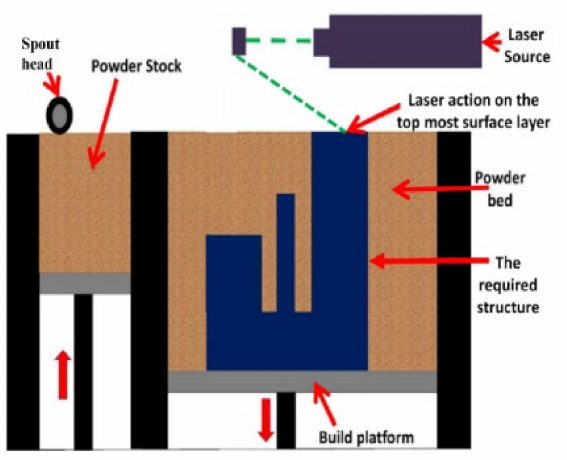
Figure 7. Schematic of SLM